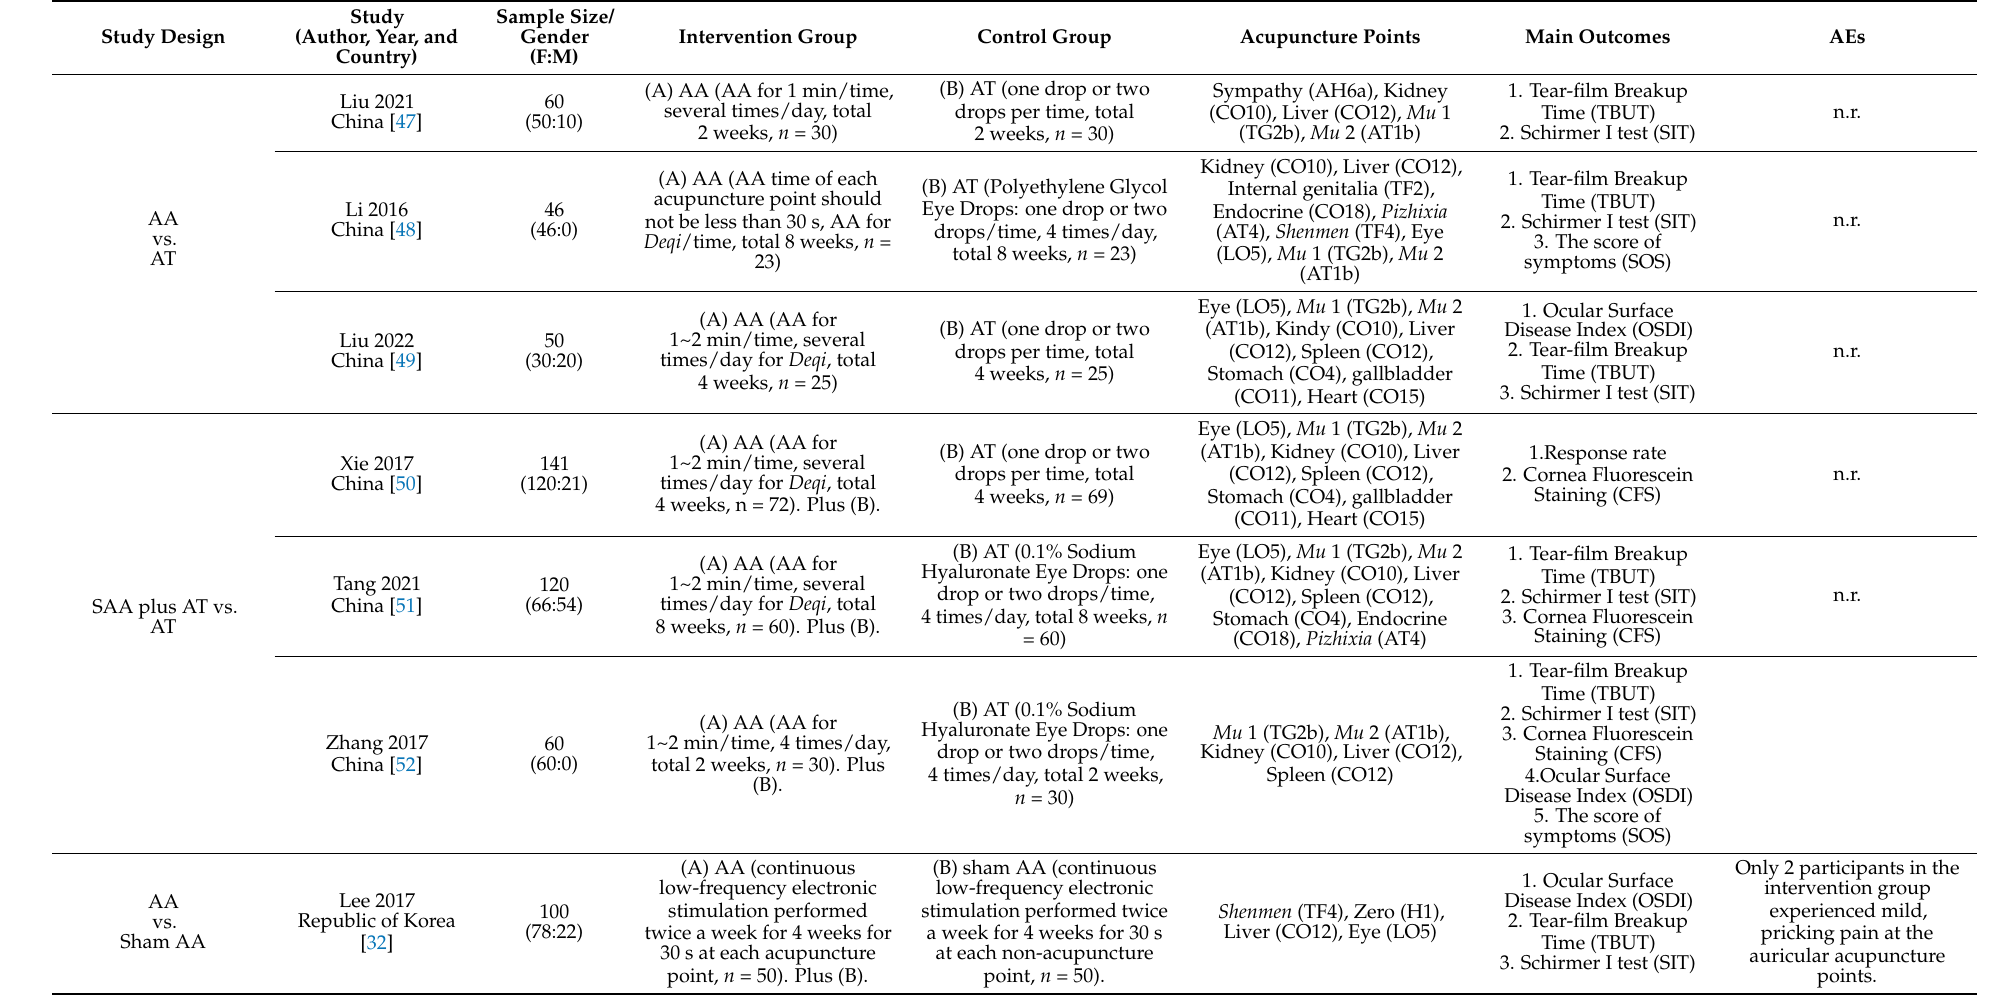
Table 1. Main characteristics of included